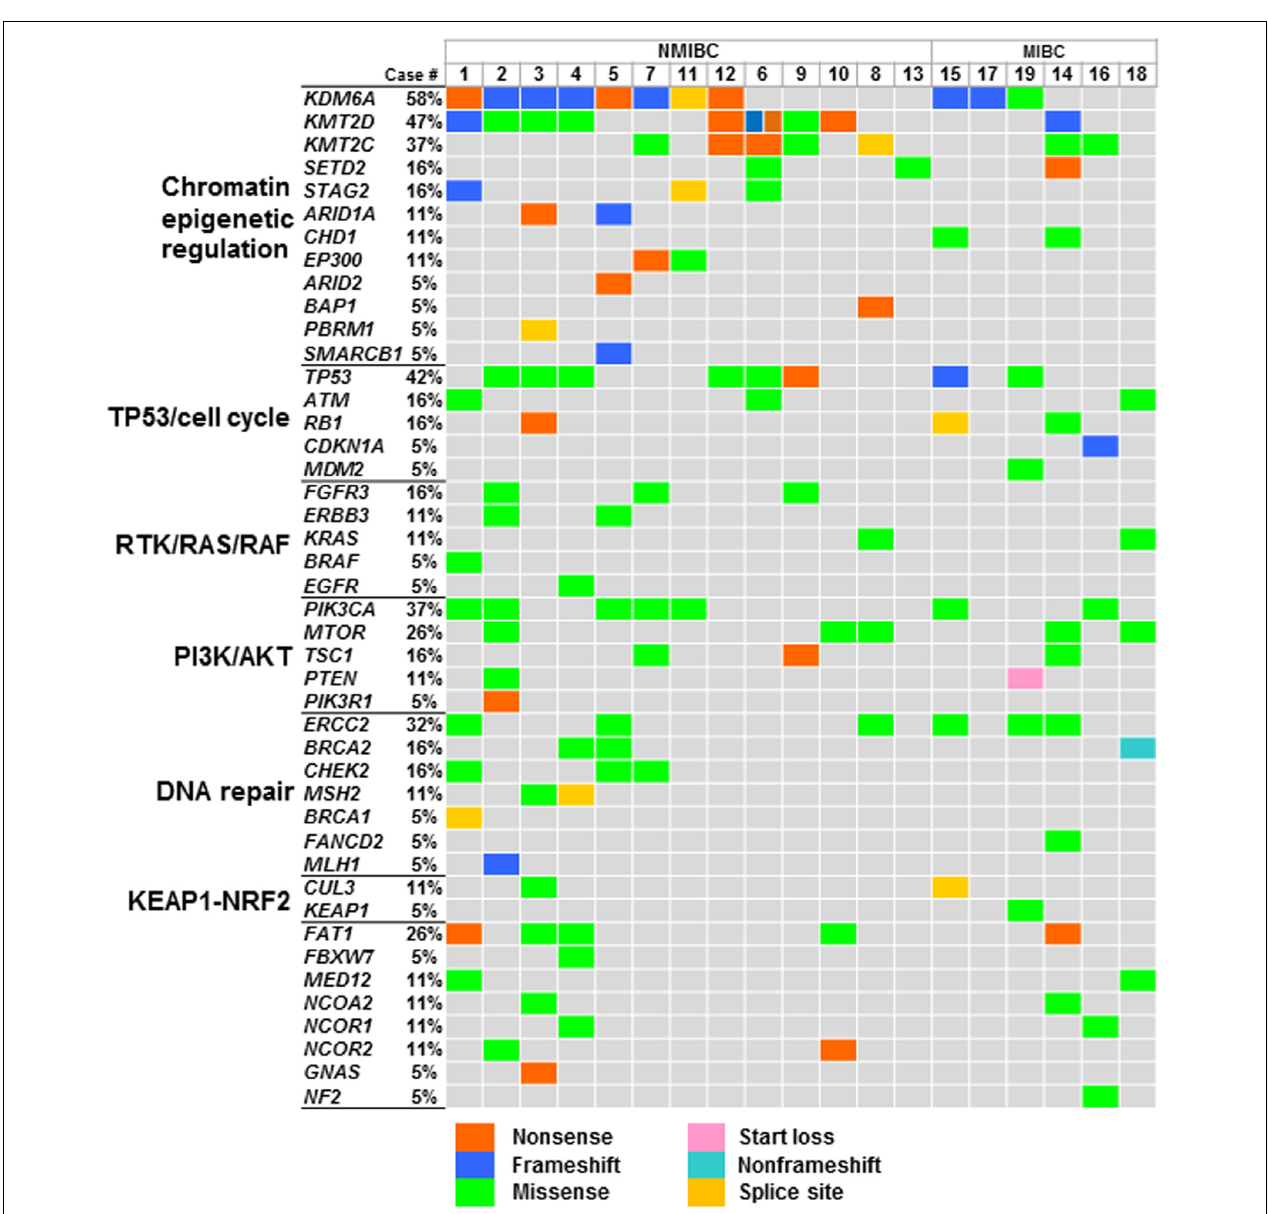
FIGURE 1 | Genomic profiles in urothelial BC. Oncoprint showing the mutated genes identified in primary tumors; mutation types are colored. Signaling pathways of genes, gene symbols, and mutational frequency are shown on the left. Abbreviation: NMIBC, non-muscle-invasive bladder cancer; MIBC, muscle-invasive bladder